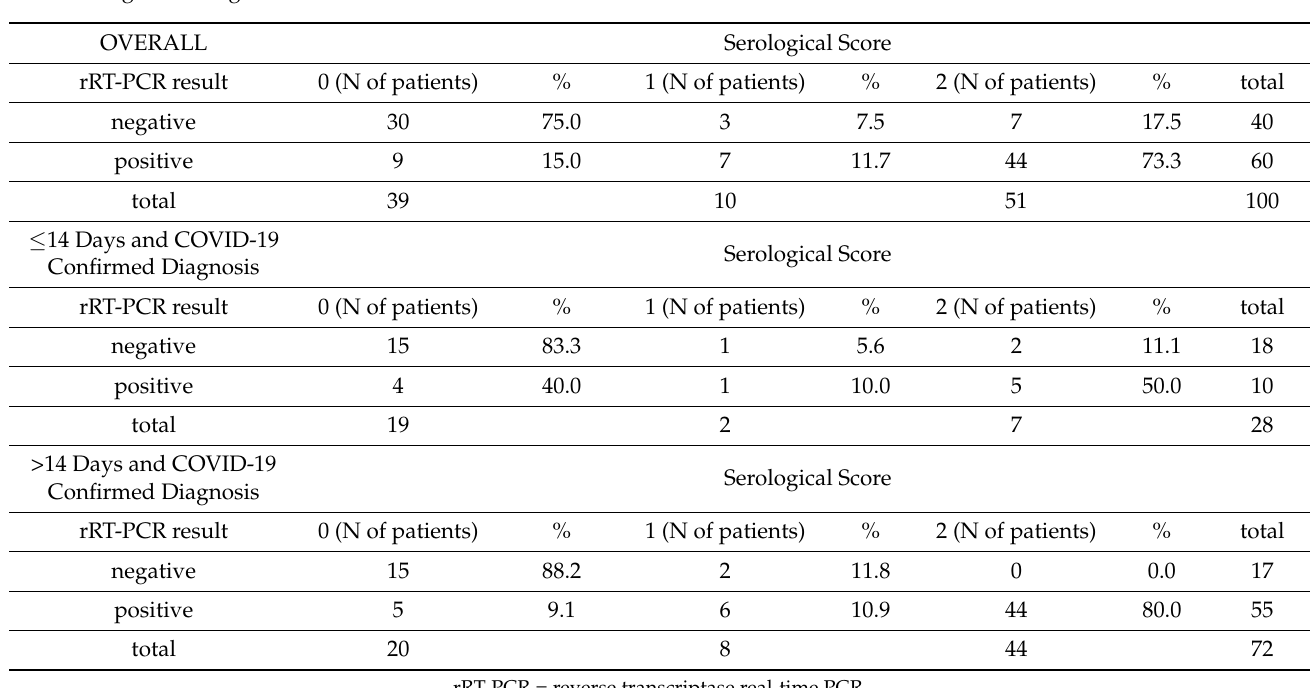
Table 3. Combined concordance of LFA and FIA tests with rRT-PCR. Serological scores indicate the number of positive tests (0 = both negative, 1 = one positive, 2 = both positive). ‘COVID-19 confirmed diagnosis’ includes as positive, in addition to the PCR-positive patients, five patients who had negative PCR testing before the onset of symptoms, but who had clear COVID-19 symptoms. They were mutually correlated, with confirmed positive contact and double-positive serological